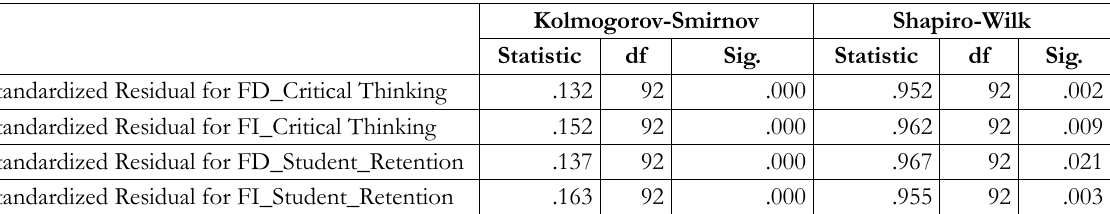
Table 13. Test of Normality